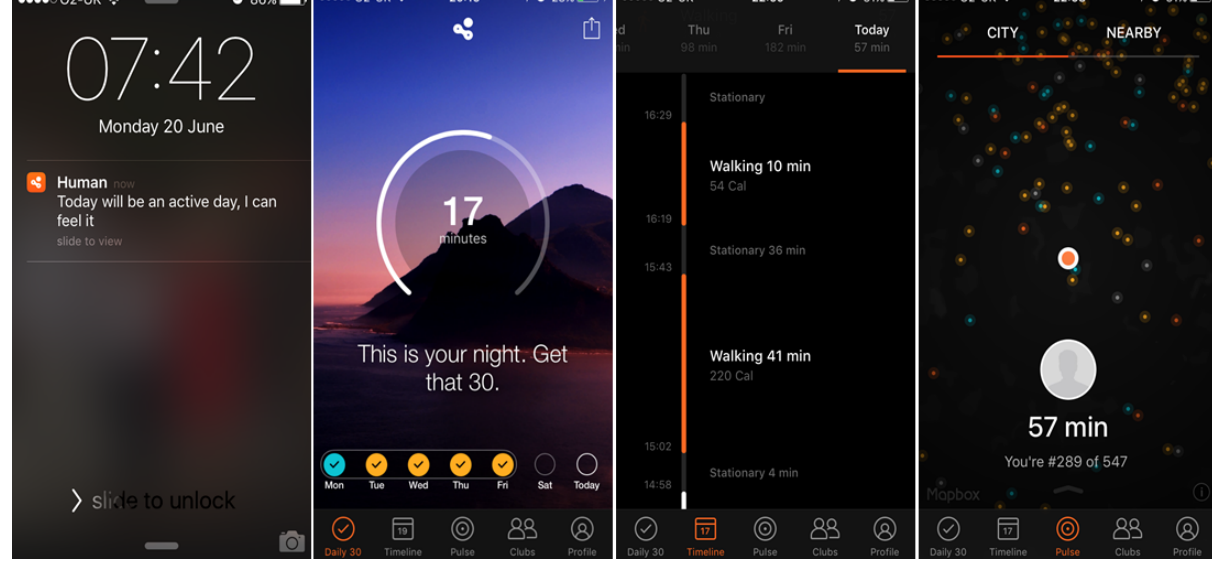
Figure 2. Screenshots of The